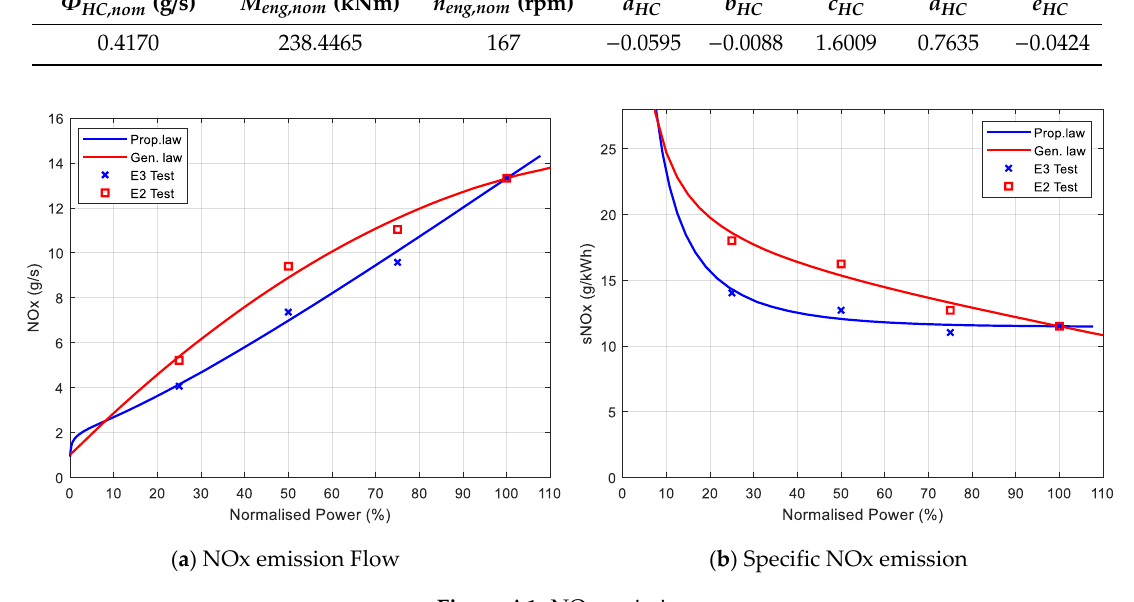
Figure A1. NOx emission.